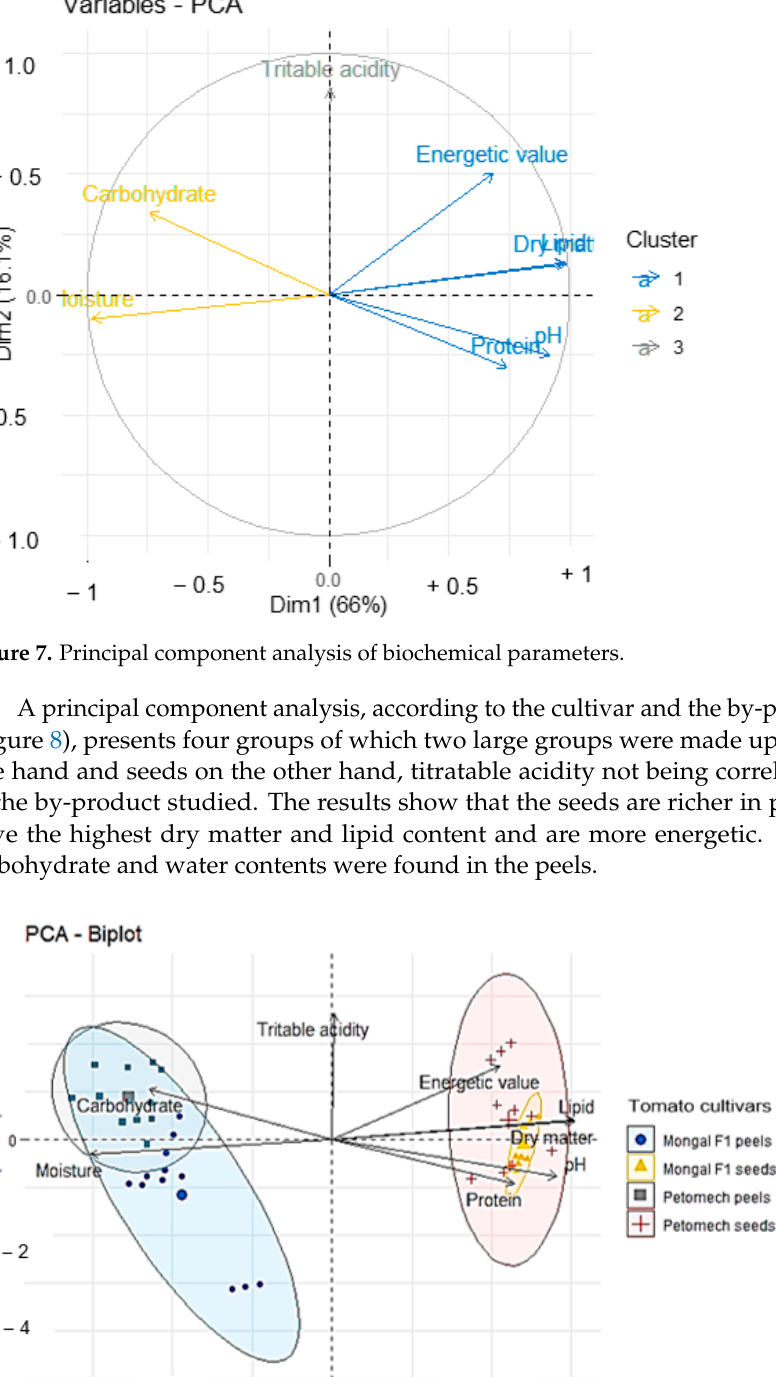
Figure 6. Hierarchical classification of tomato parameters.